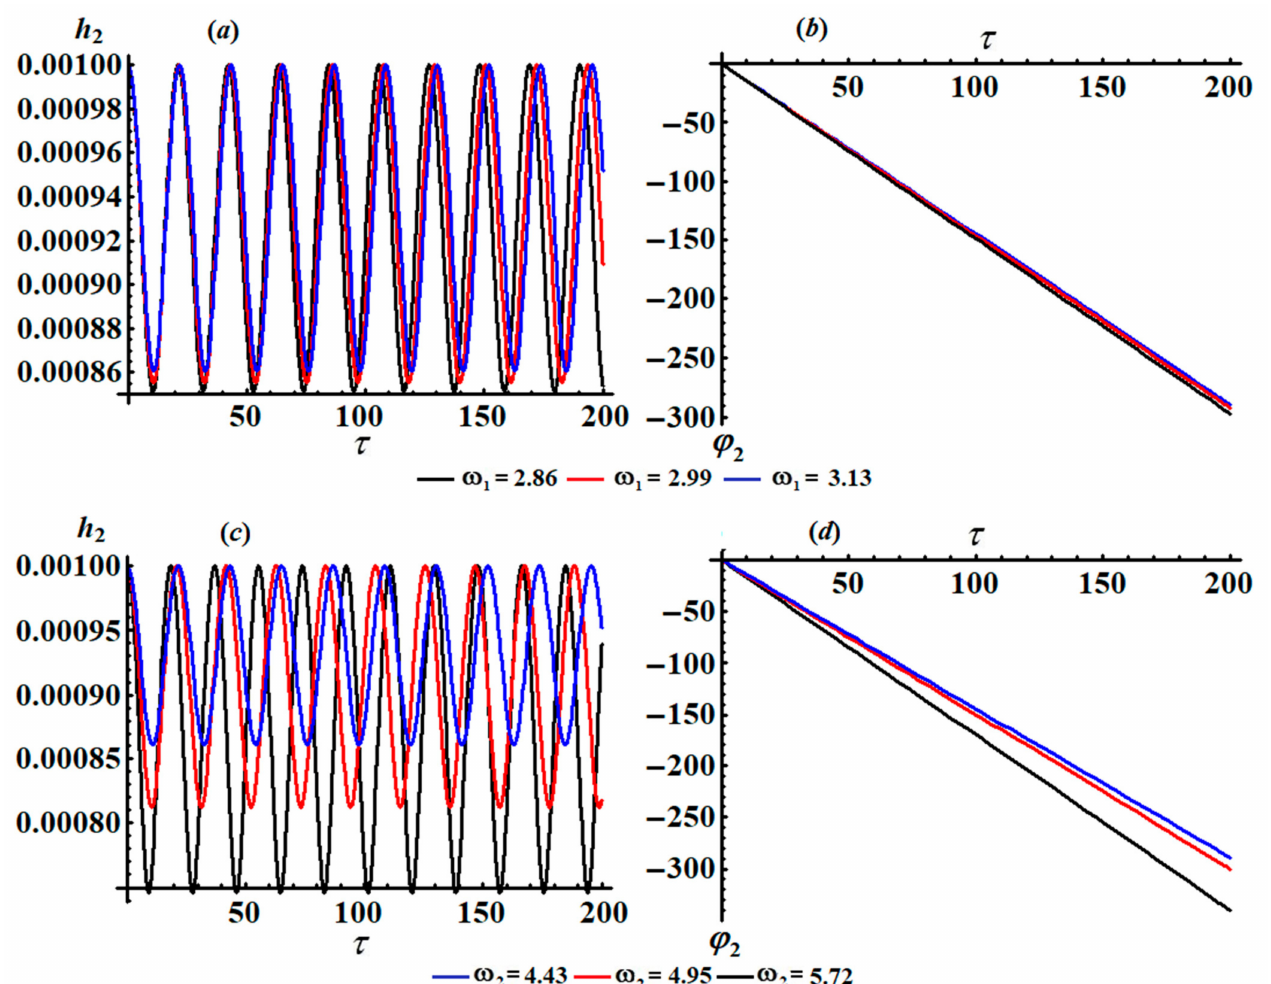
Figure 3. Sketches of the modulation of the amplitude h 2 and modified phase ϕ 2 : ( a,b ) at ω 1 = ( 2.86,2.99,3.13 ) , ( c,d ) at ω 2 = ( 4.43,4.95,5.72 )